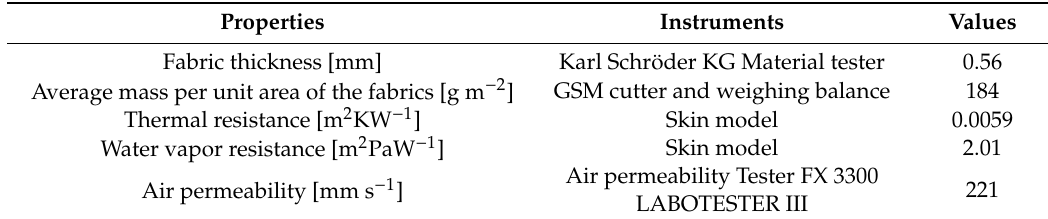
Table 1. Characteristics of fabric.